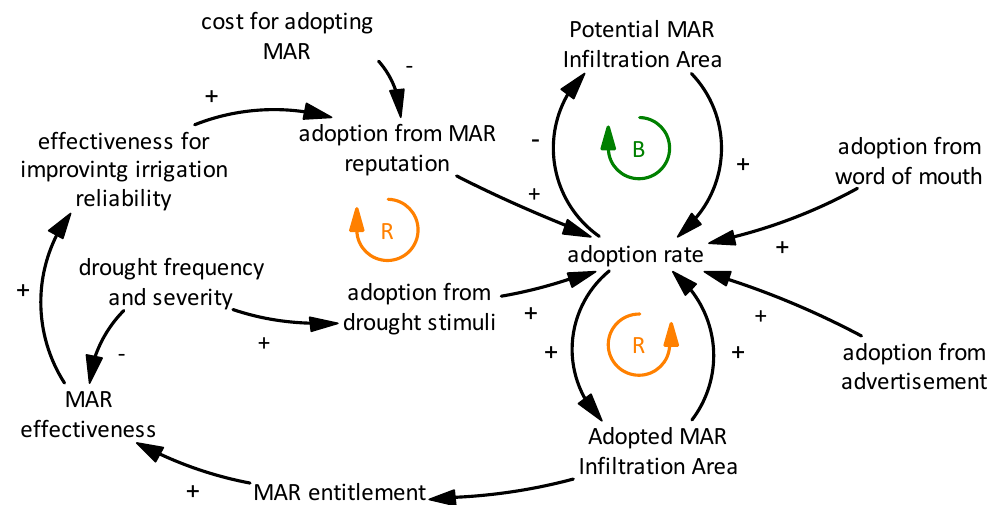
Figure 7. Causal Loop Diagram for MAR adoption behavior. The ‘+’ sign with the arrow indicates two variables changing in the same direction, and the ‘ − ’ sign indicates the opposite direction. Reinforcing loops (positive feedback, labeled as ‘R’), enhance the system to keep growing over time, amplifying the impact of the disturbance, whereas balancing loops (negative feedback, labeled as ‘B’), wear down or balance the system over time, negating the impact of the disturbance.